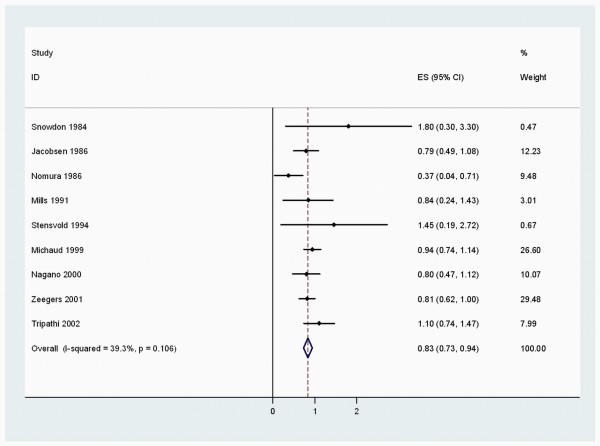
Summary RRs of bladder cancer for coffee drinkers versus non/lowest drinkers from included studies. Squares represent study-specific relative risk estimates (size of the square reflects the study-specific statistical weight, that is, the inverse of the variance); horizontal lines represent 95% CIs; diamonds represent summary relative risk estimates with corresponding 95% CIs.